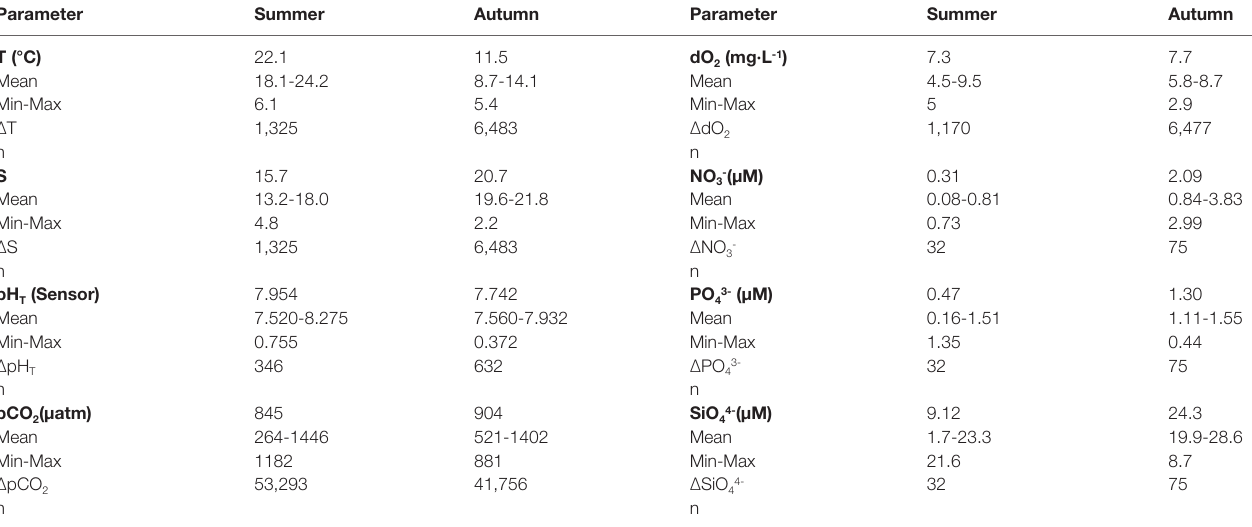
TABLE 2 | Summary statistics for in situ pHT and ancillary data from summer and autumn deployments.